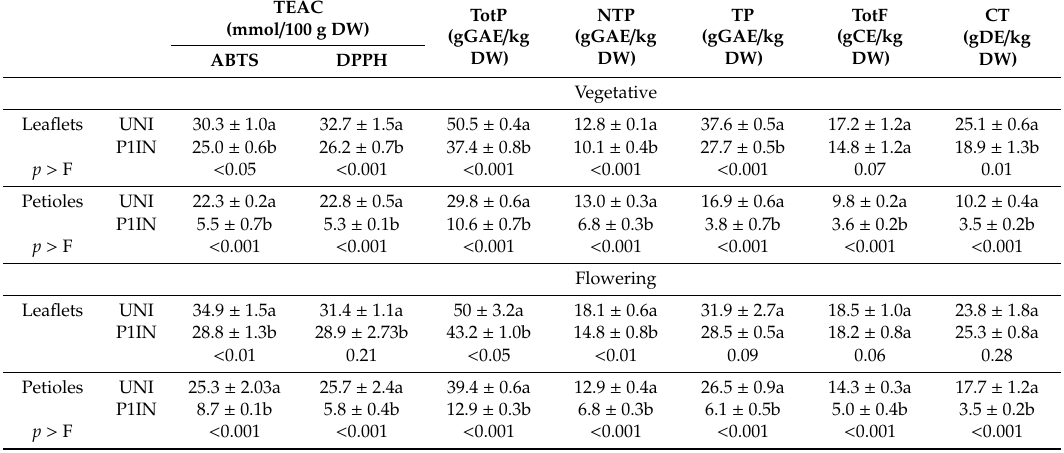
Table 8. Trolox equivalent antioxidant capacity (TEAC) by ABTS ((2,2 (cid:48) -azinobis (3-ethylbenzothia zoline-6-sulphonic acid) diammonium salt)) and DPPD (1,1-diphenyl-2-picrylhydrazyl) assays, total phenolics (TotP), non-tannic phenolics (NTP), tannic phenolics (TP), total flavonoids (TotF), and extractable condensed tannins (CT) of sulla leaf fractions (mean ± standard